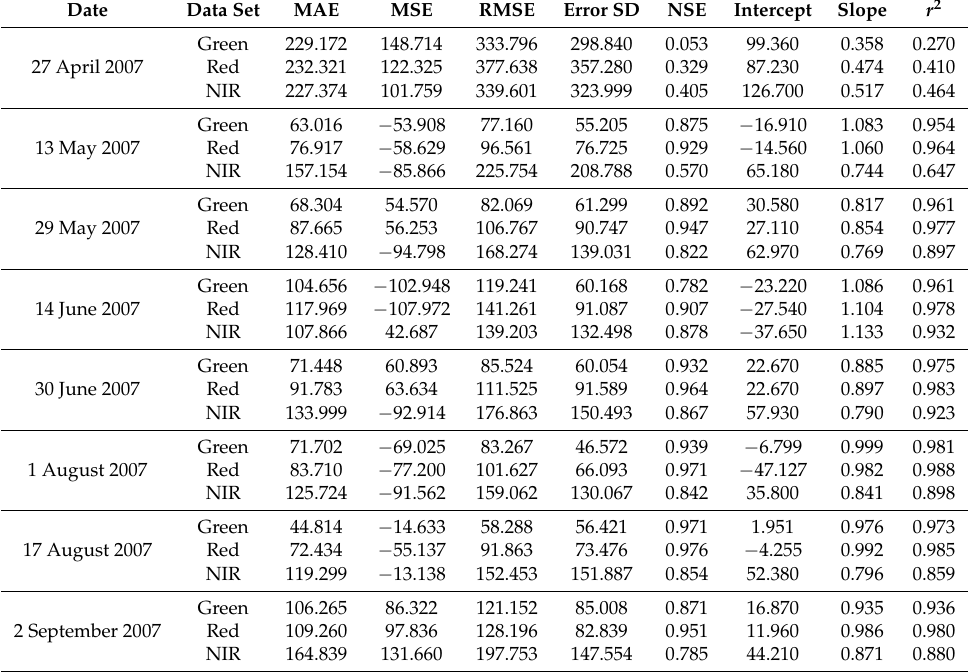
Table 5. Error and correlation statistics for full scene difference of observed and predicted green, red, and near-infrared (NIR) reflectance values. The STARFM-predicted synthetic image was created using two pairs of training